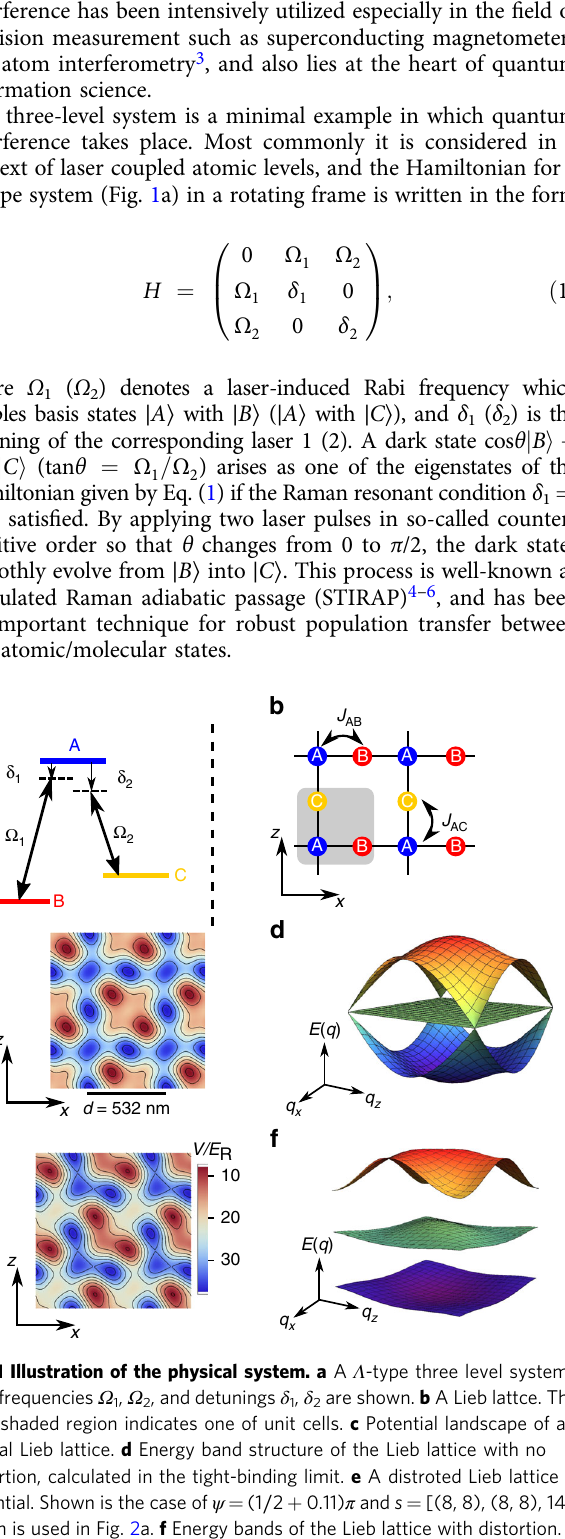
Fig. 1 Illustration of the physical system. a A Λ -type three level system. Rabi frequencies Ω 1 , Ω 2 , and detunings δ 1 , δ 2 are shown. b A Lieb lattce. The gray shaded region indicates one of unit cells. c Potential landscape of an optical Lieb lattice. d Energy band structure of the Lieb lattice with no distortion, calculated in the tight-binding limit. e A distroted Lieb lattice potential. Shown is the case of ψ = (1 ∕ 2 + 0.11) π and s = [(8, 8), (8, 8), 14], which is used in Fig. 2a. f Energy bands of the Lieb lattice with distortion. If the phase of the diagonal lattice is shifted, band gaps become large and the Dirac cone